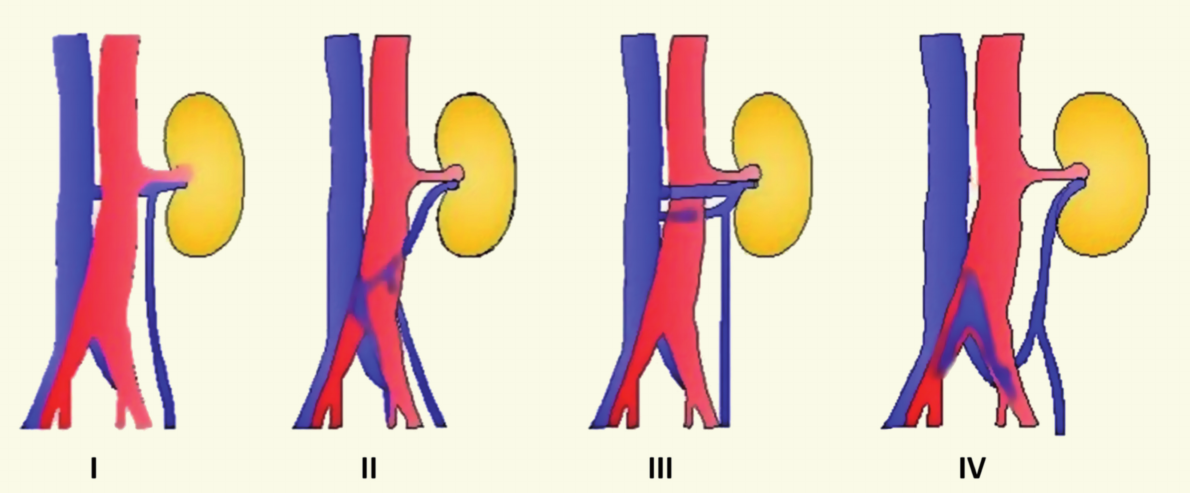
figure 1- Types of left renal vein anomalies: Type I Retroaortic Left renal vein (RLRv) join the Ivc in the orthotopic position, Type II RLRv join the Ivc at level L4-5, Type III - circumaortic left renal vein, Type Iv renal vein joins the left common iliac